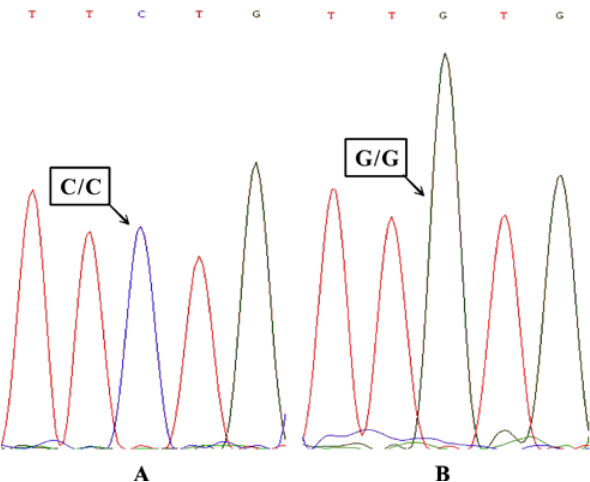
Figure 1: The single nucleotide polymorphism rs121964871 variation detection in promoter region of CDH1gene. A: homozygous wild- type, B: homozygous